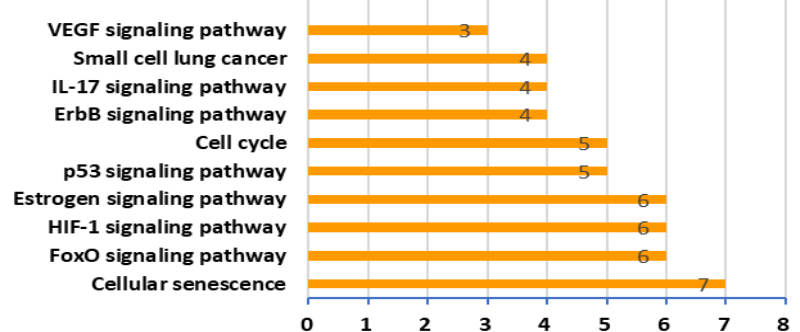
Figure 5. Main pathways enriched by major targets. The top 10 pathways selected to demonstrate the crucial biological actions of major targets. The abscissa stands for target counts in each pathway, and the ordinate stands for main pathways.